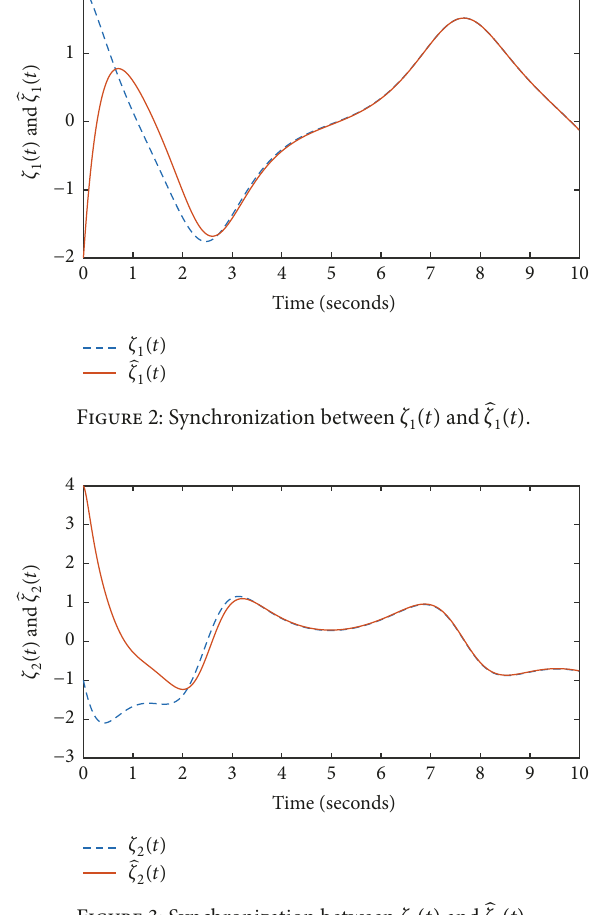
Figure 3: Synchronization between 𝜁 2 (𝑡) and